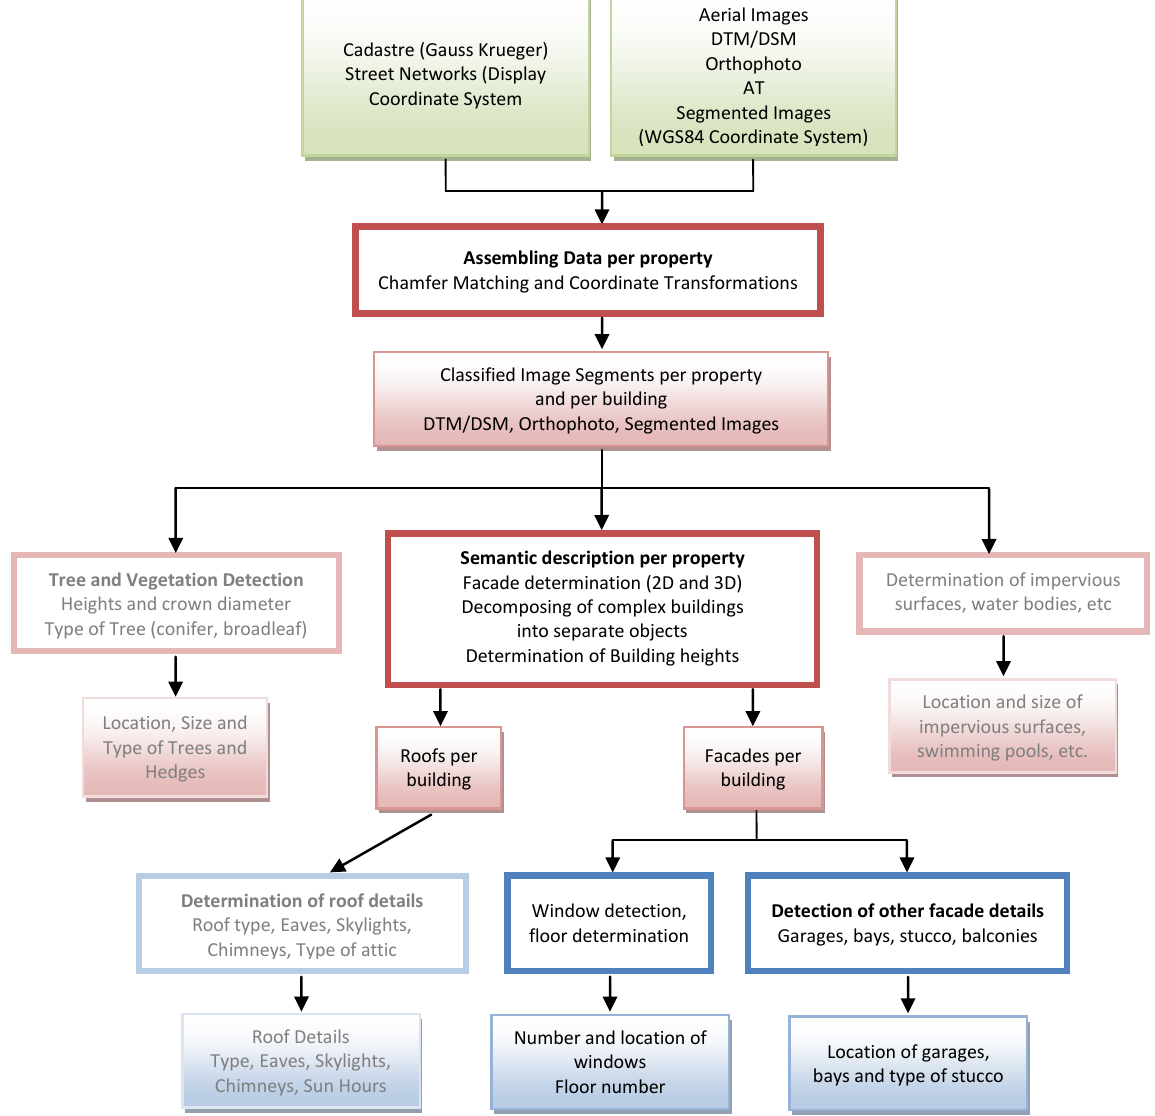
Figure 2. Diagram of the proposed work flow to characterize real properties from aerial images and associated cadastral data (performed processing steps